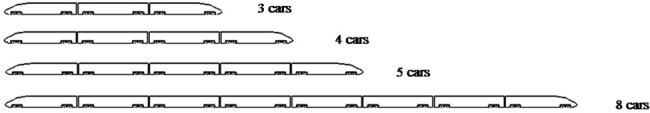
The four train configurations of the high-speed train, with 3, 4, 5, 8 cars.